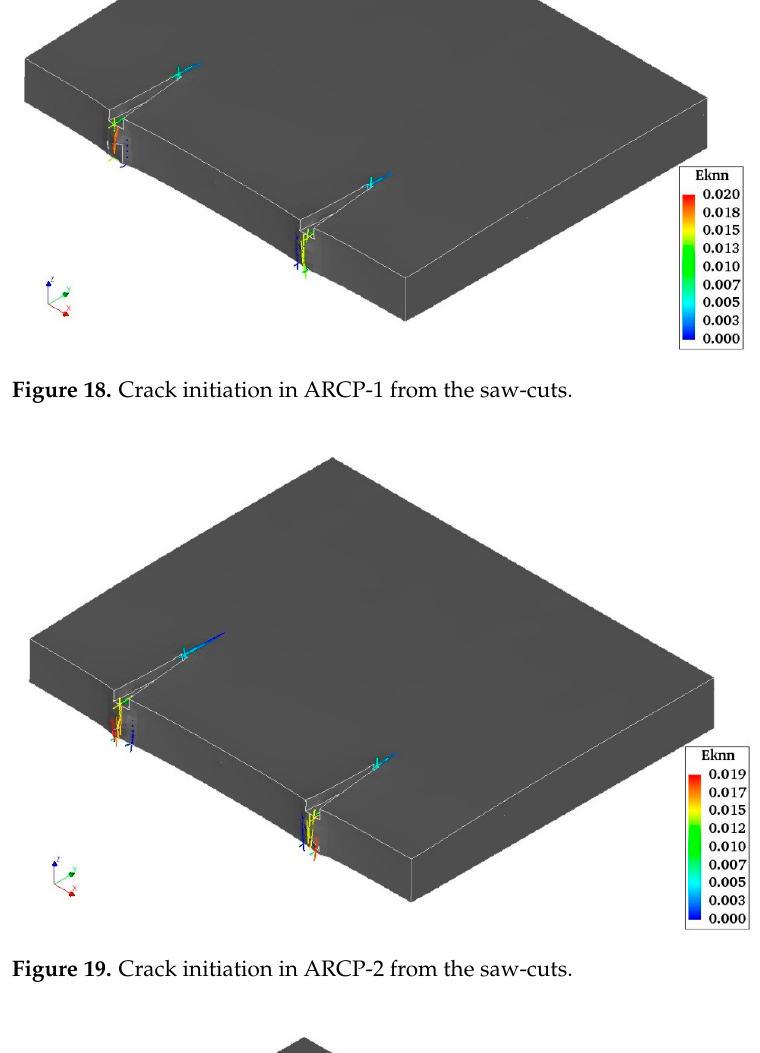
Figure 21. The predicted transverse crack pattern of ARCP-2. Moreover, the development of crack strain with respect to time over the saw-cut tips demonstrated in Figure 22 illustrates no prominent difference between CRCP and ARCP. Based on the field observations of cracking developments discussed above, it may justify the lesser amount of continuous steel bars in the active crack control ARCP segment in between the saw-cuts to hold the passively formed cracks tightly between the actively induced cracks. Hence, a considerable amount of initial construction cost could be re- duced by eliminating the unnecessary longitudinal continuous steel bars in between the crack inducers (saw-cuts) without compromising the pavement performance. The longitudinal reinforcing steel bars in the CRCP and ARCP segments just ahead of saw-cut tips are selected for evaluating the maximum steel stress distribution. Figure 23 demonstrates the maximum steel stress distribution in the continuous steel bar of CRCP and partial steel bars of ARCP-1 and ARCP-2. It can clearly be observed that the steel stress peaks occur exactly over the saw-cut tips. In between the saw-cuts, the stress variations converge to zero, which indicates the effectiveness of the active crack control method to induce cracks at the desired locations. It may translate that the continuous steel bars between the crack inducers (saw-cuts) across the whole width of the concrete slab are unnecessary when no passive cracks are formed. As demonstrated in Figure 23, the con- tinuous steel bar and partial steel bar experience the same stress peaks only over the saw-